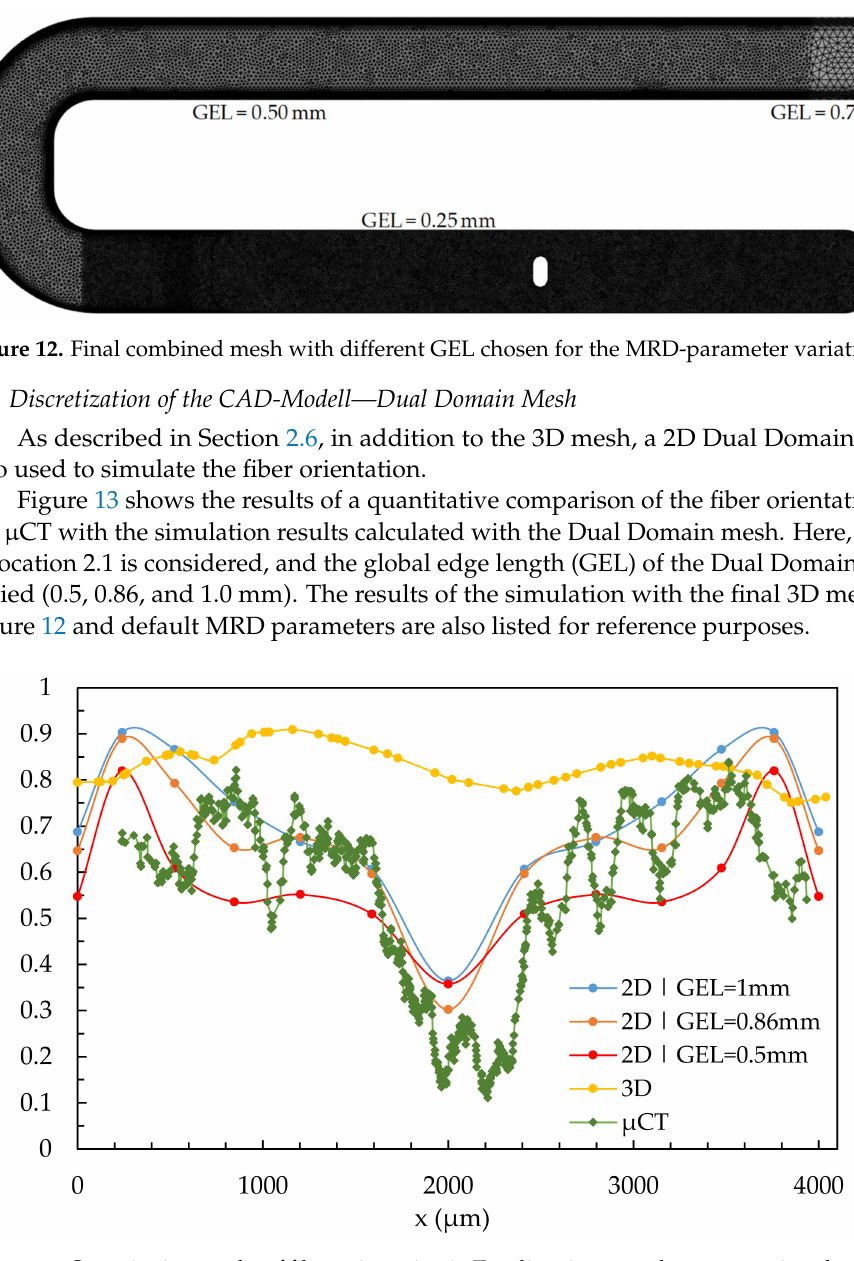
Figure 13. Quantitative results of fiber orientation in T zz -direction over the cross-section characterized by µ CT and predicted by the Dual Domain mesh in region 2 under variation of the GEL at location